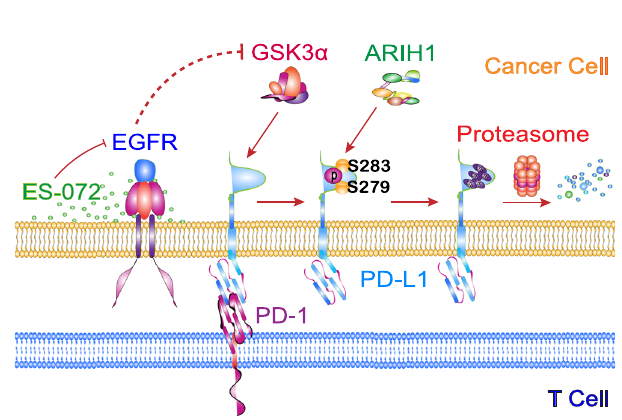
Fig. 7 Schematic model for GSK3 α -promoted and ARIH1-mediated PD-L1 degradation. GSK3 α phosphorylates PD-L1 at Ser279 and Ser283. This phosphorylation promotes the binding of PD-L1 with ARIH1, leading to PD- L1 ubiquitination and proteasomal degradation. This image was created by the fi rst